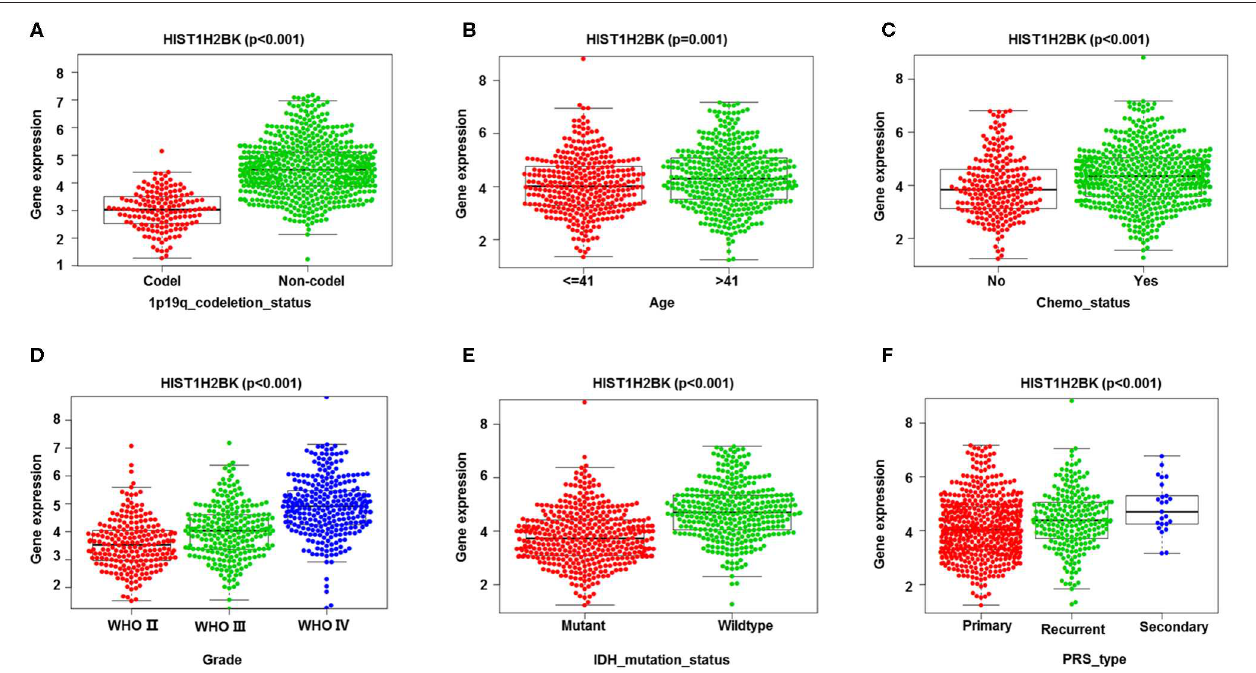
FIGURE 3 | Correlation analysis between HIST1H2BK expression and clinical characteristics using the CGGA database (LGG + GBM, n = 749). Differential expression of HIST1H2BK was significantly related to (A) 1p19q codeletion status (Codel, n = 155; Non-codel, n = 594), (B) age ( ≤ 41, n = 342; > 41, n = 407), (C) chemo status (No, n = 229; Yes, n = 520), (D) grade(WHO II, n = 218; WHO III, n = 240;WHO IV, n = 291), (E) IDH mutation status (Mutant, n = 410; Wildtype, n = 339), and (F) PRS type (Primary, n = 502; Recurrent, n = 222; Secondary, n = 25).